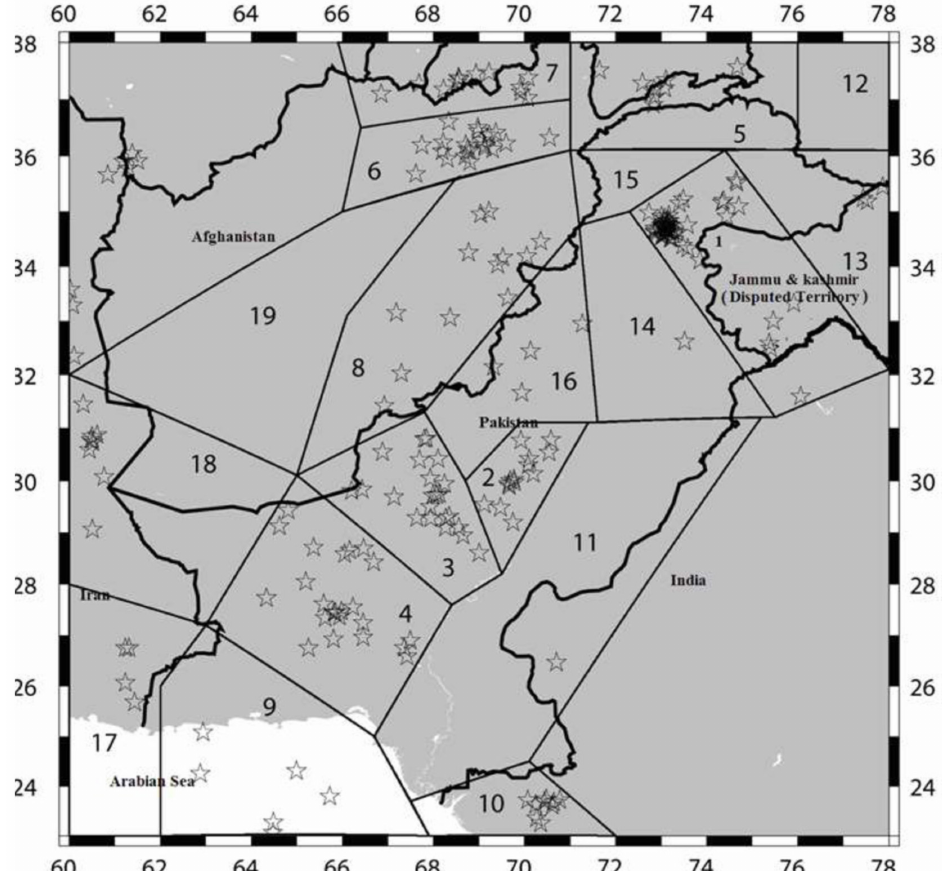
Figure 4. Seismic zones of Pakistan as used in the present